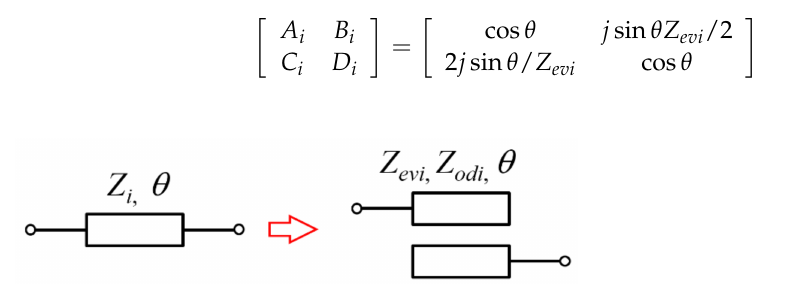
Figure 3. The i th CLS is substituted by a single TL.